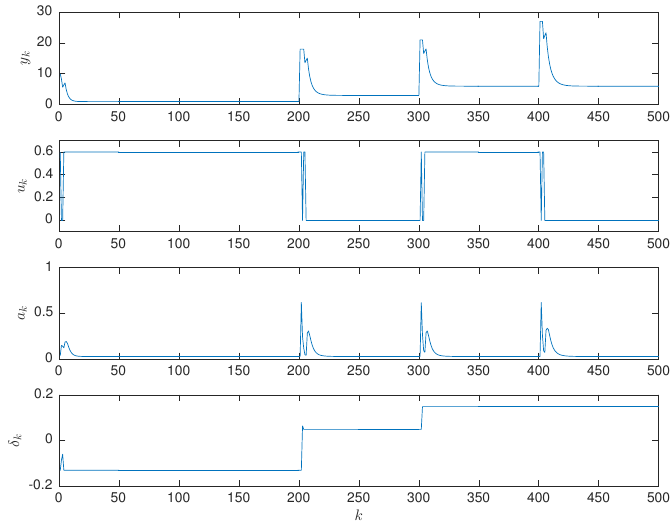
Figure 5. Performance of the discrete actuator PIESC for Example 1. The top plot shows the progression of the cost function. The corresponding input variable is shown in the middle plot. The bottom plot shows the resulting amplitude of the dither